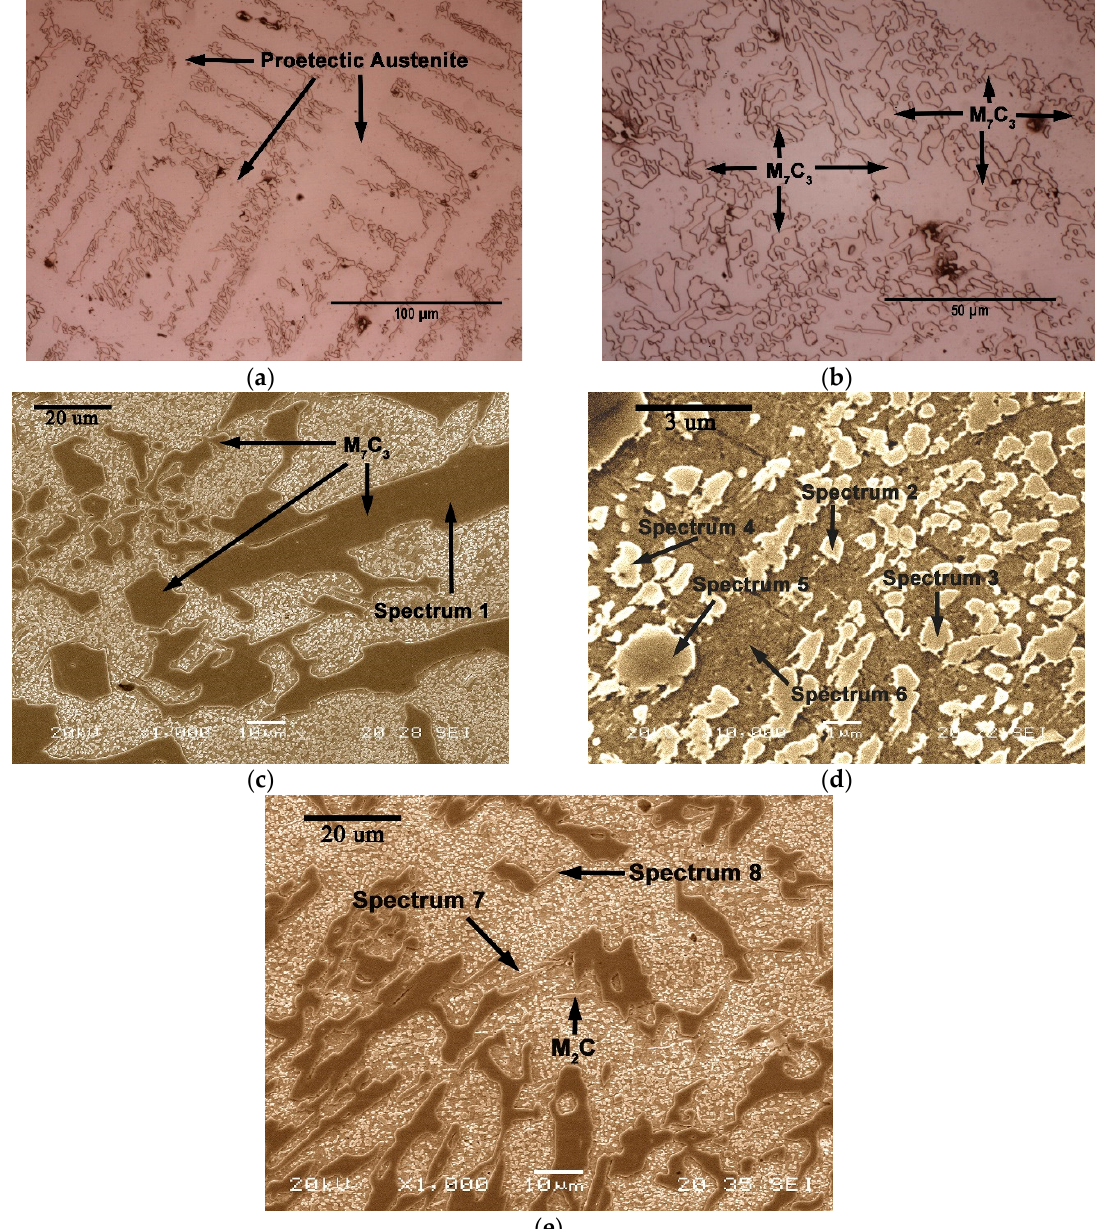
Figure 1. Microstructure as-cast. ( a ) The dendritic growth of pro-eutectic austenite can be seen. Micrograph obtained by optical microscope (magnification of 500 × ); ( b ) eutectic carbides M 7 C 3. can be seen. Micrograph obtained by optical microscope (magnification of 1000 × ); ( c ) eutectic carbides of the type M 7 C 3 can be seen. Micrograph obtained by scanning electron microscope (magnification of 1000 × ); ( d ) presence of secondary carbides of the type M 7 C 3 and M 23 C 6 . Micrographic obtained by scanning electron microscopy (magnification of 10,000 × ); ( e ) presence of mixed eutectic carbides of the type M 2 C, associated with the Mo (magnification of 1000 × ).